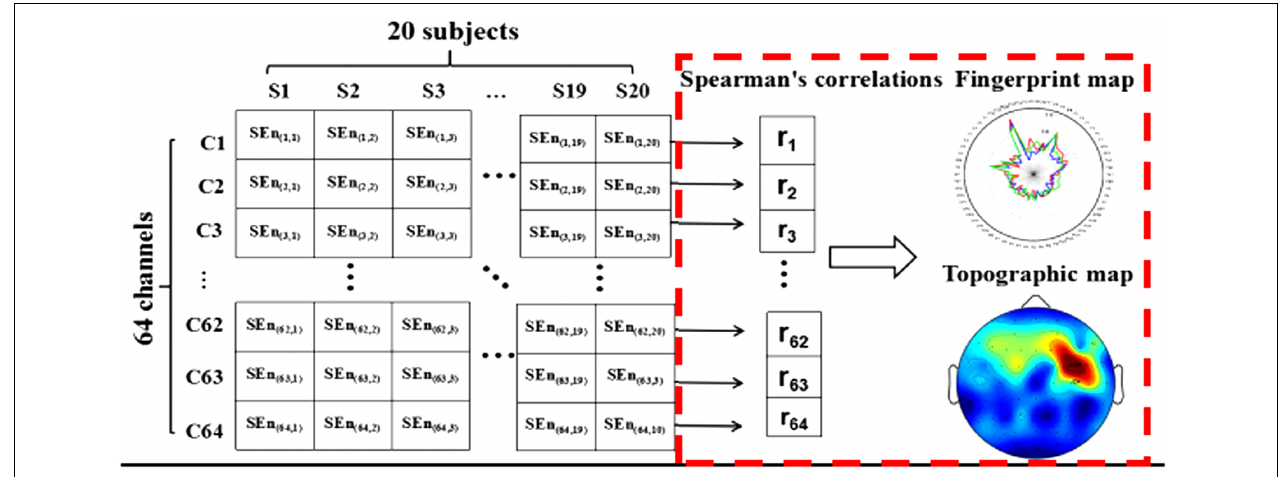
FIGURE 2 | The analysis process of scalp spatial distribution for the relationship between spectral entropy and subjects’ SRT